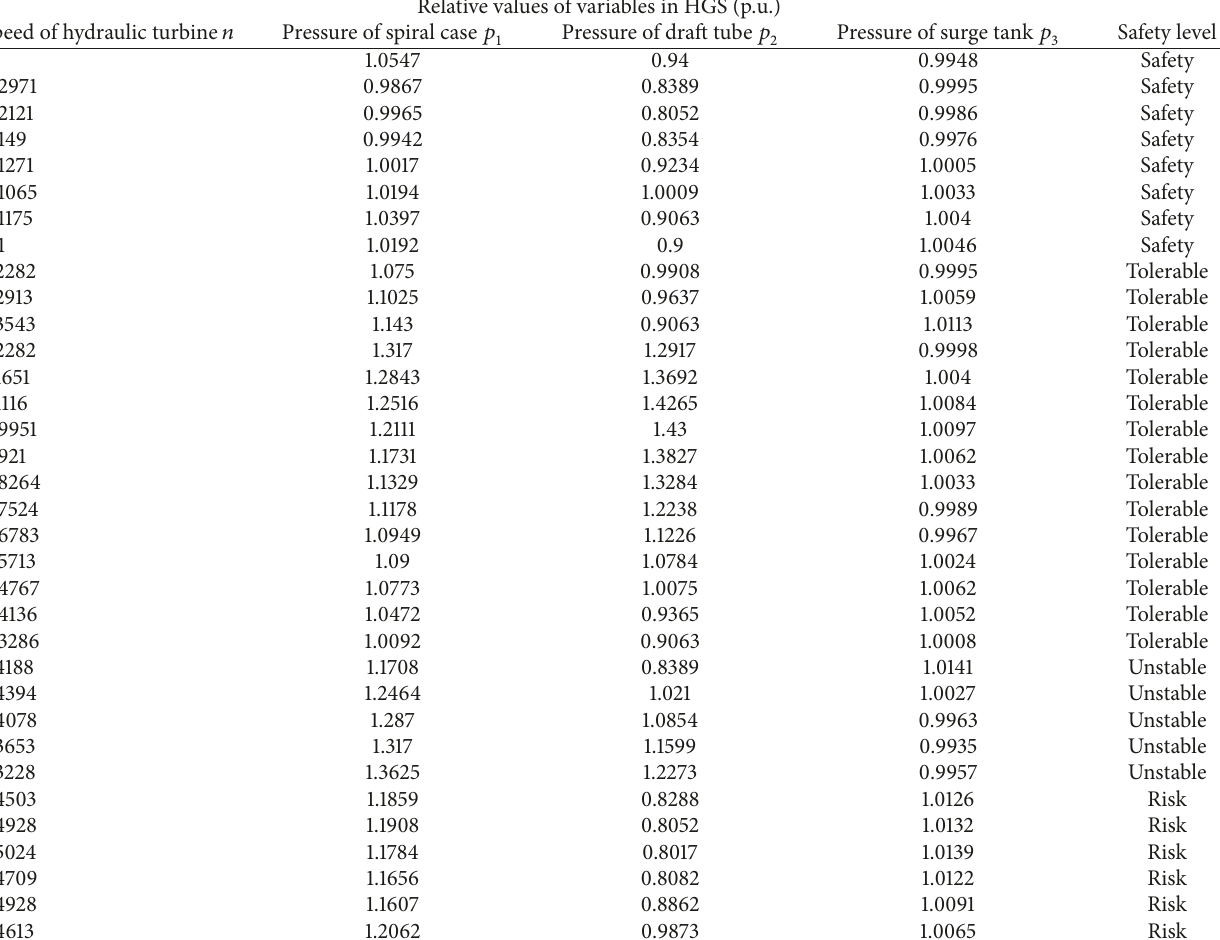
Table 3: Training data of the HGS in the load rejection transient process. Relative values of variables in HGS